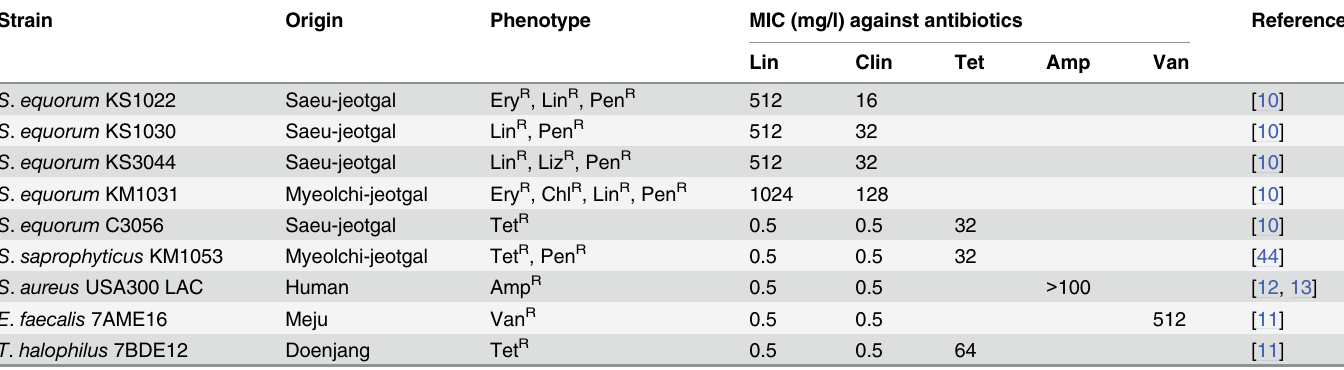
Table 1. Bacterial strains examined in this study and corresponding MICs.